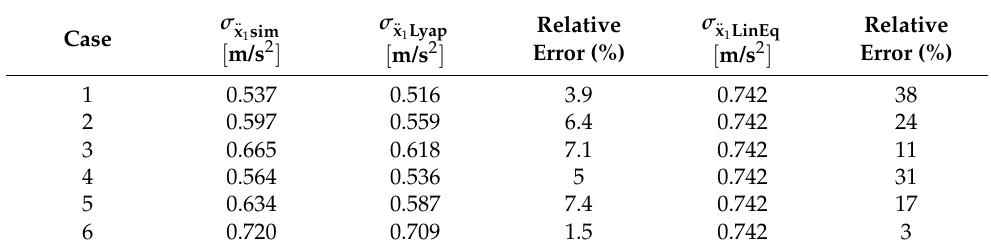
Table 4. The std values and relative errors for absolute accelerations.